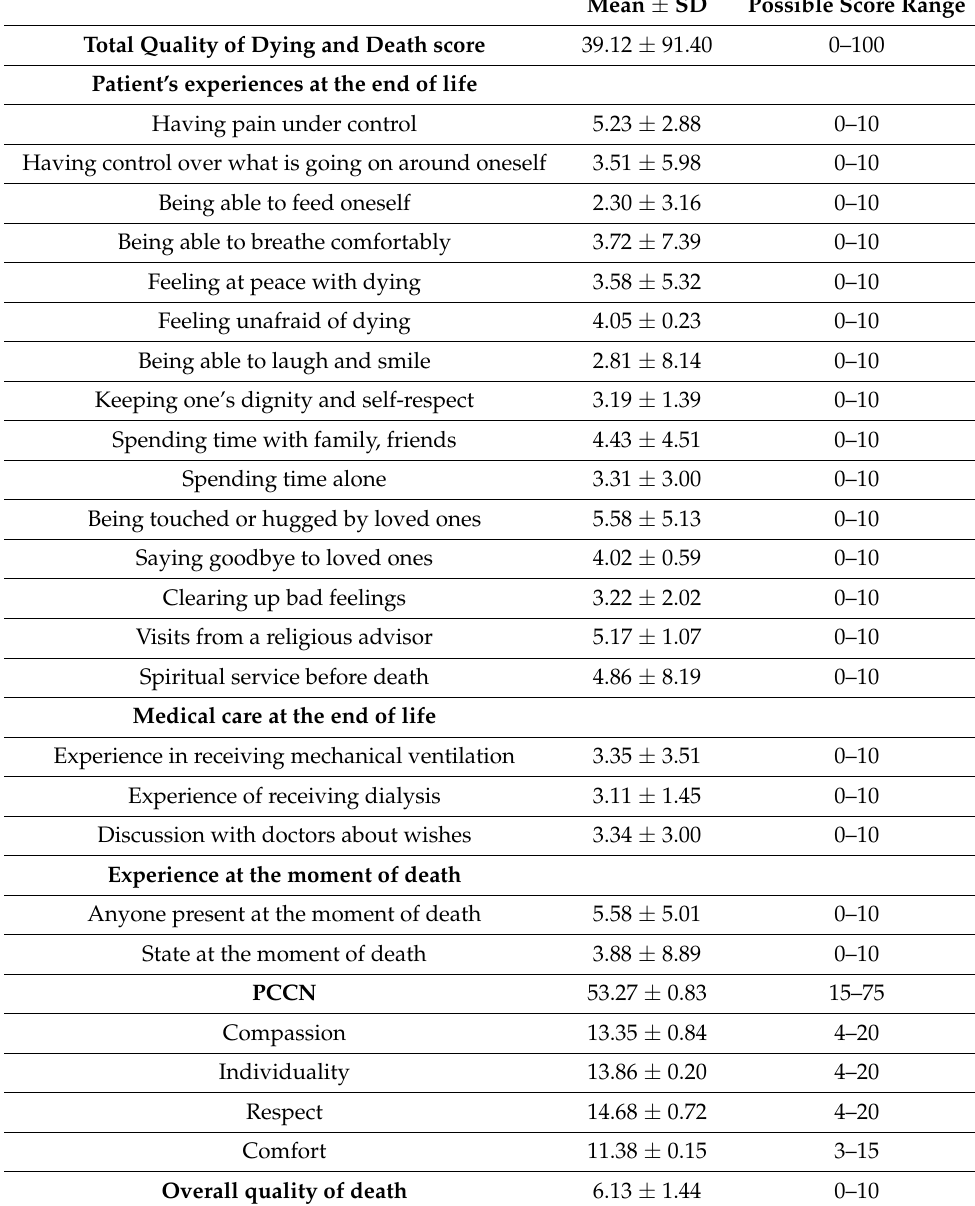
Table 1. QODD, PCCN, and overall quality of death as perceived by nurses (N =